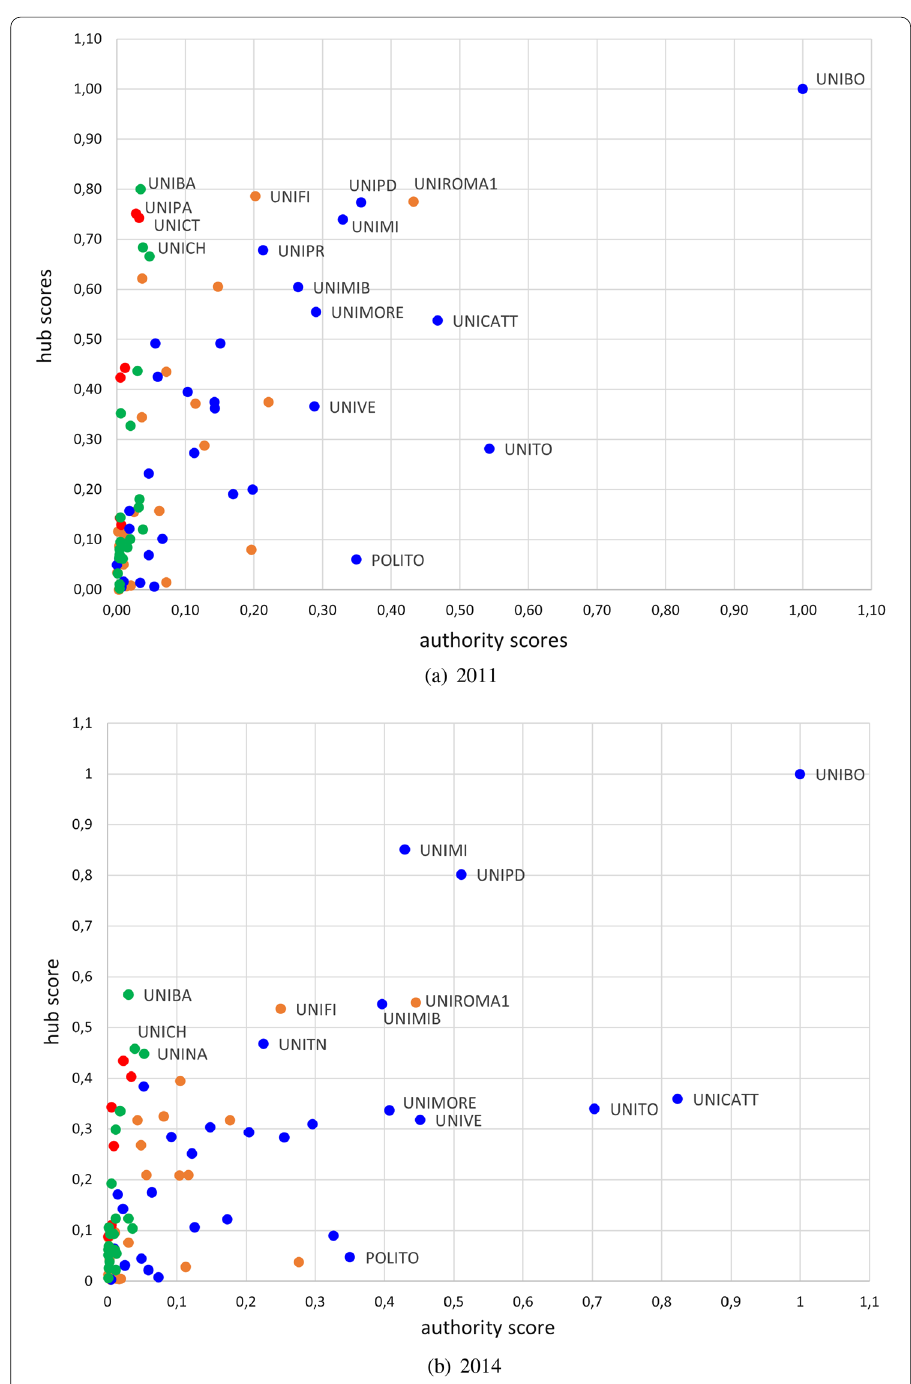
Fig. 4 Scatterplots of hub and authority scores at university level of the 2011–12 and 2014–15 student cohorts according to the Italian macro-areas (blue